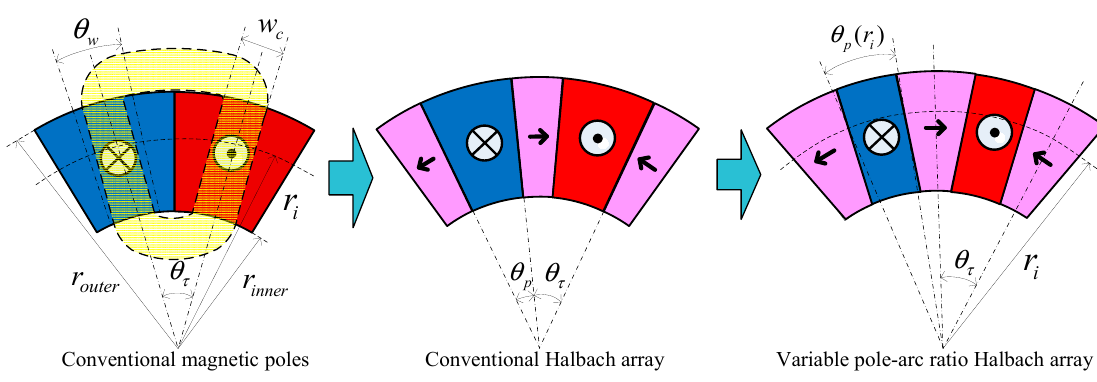
Figure 2. Structures of conventional and variable pole-arc ratio Halbach arrays.